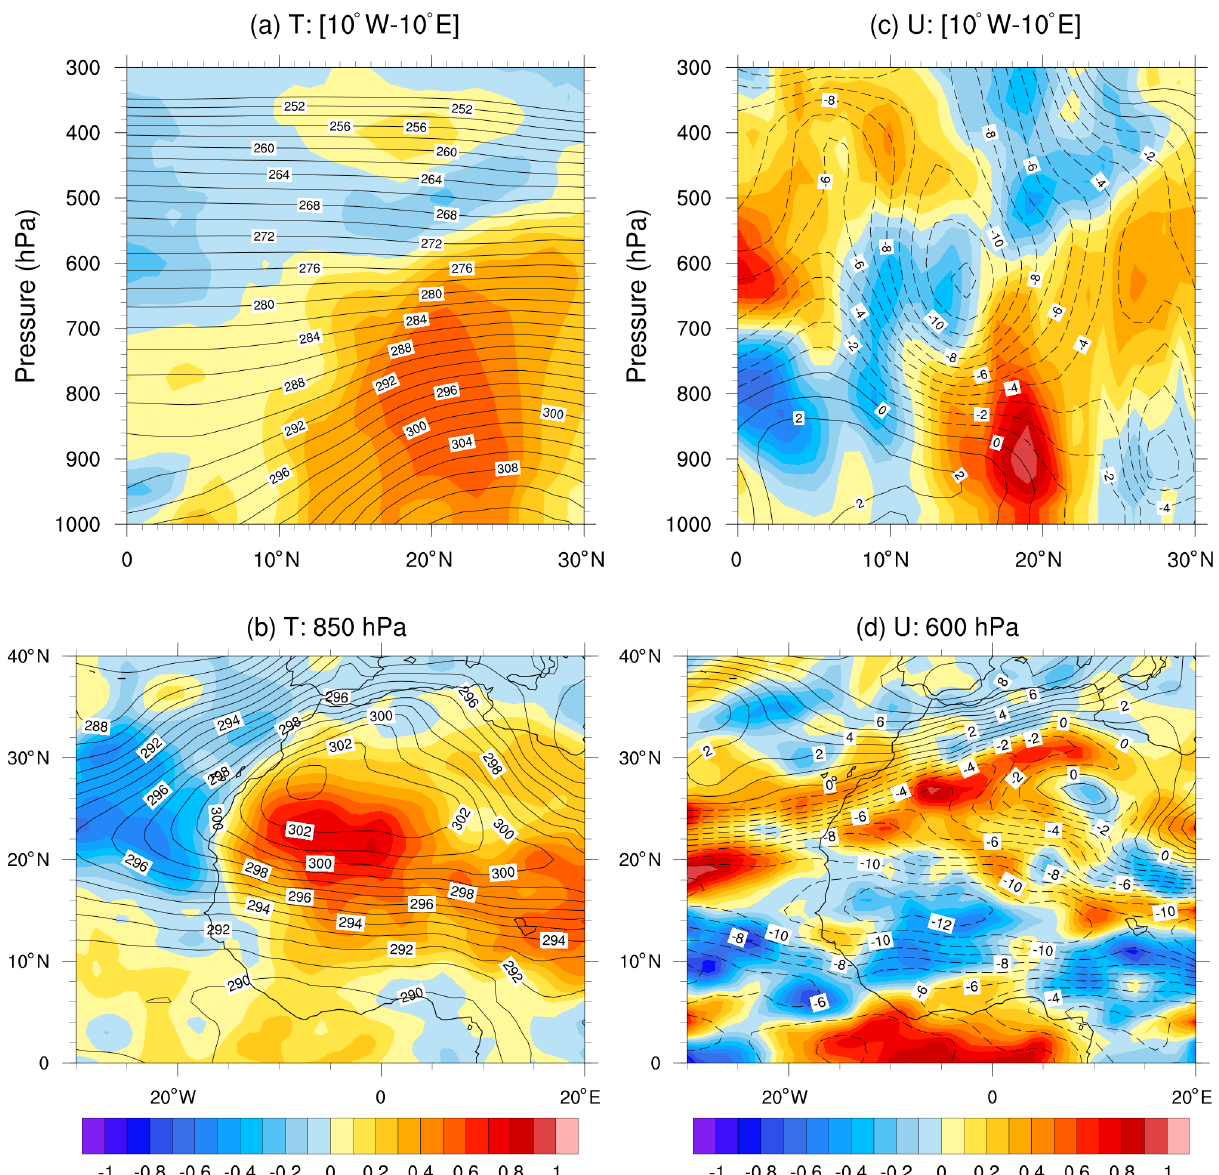
Figure 5. Vertical and horizontal cross sections of the CTL analysis (contours) and the AER–CTL analysis difference (colors) for (a,b) tem- perature, T , and (c,d) zonal wind, U . The vertical sections (a,c) are zonally averaged from 10 ◦ W to 10 ◦ E, while horizontal sections (b,d) are taken at specified pressure levels. Contour/color units are in (a,b) kelvin (K) and (c,d) meters per second (ms − 1 ). The fields are time averaged from 1–28 August